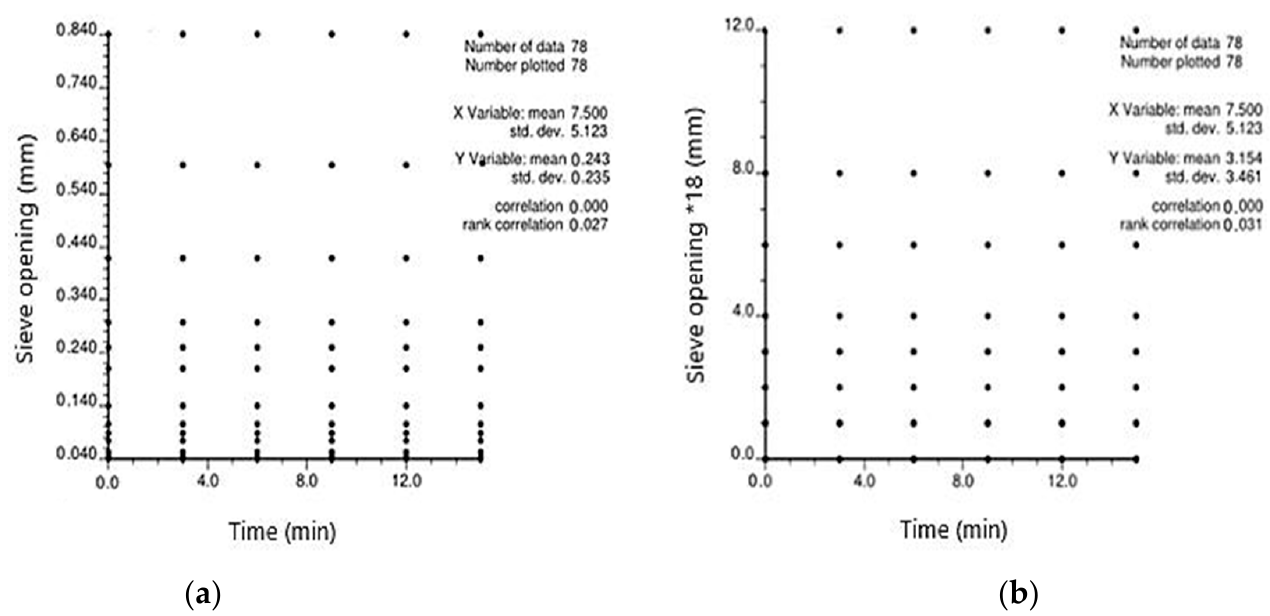
Figure 3. Spatial positioning of the experimental data: ( a ) No adjustment of the spatial position (on the Y-axis, it is presented in this format by default for the GSlib program) and ( b ) adjusting the spatial position.